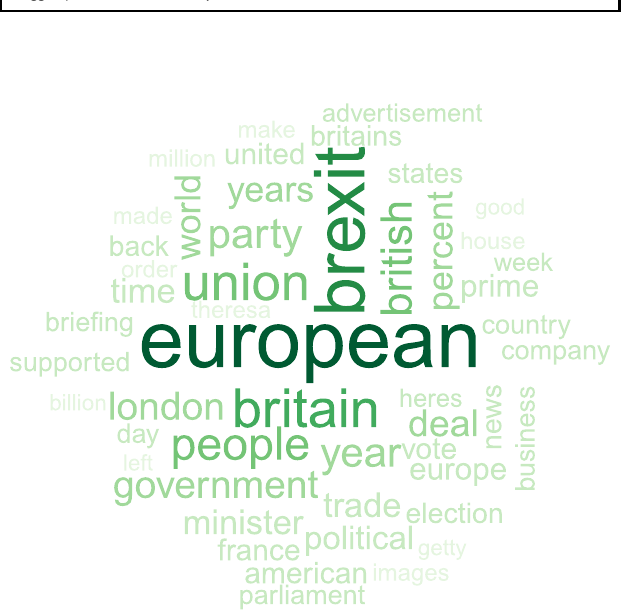
Fig. 3 Word cloud representation of the top 50 words used in the NYT in their coverage of Brexit. Size of each word corresponds to its frequency, as does font color. The darker the font, the greater the